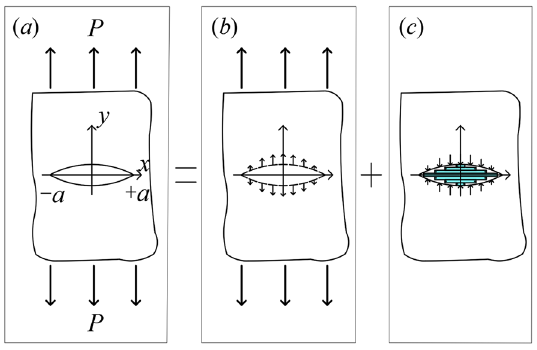
Figure 2 Crack edge dislocation based on Bueckner’s theorem [31]